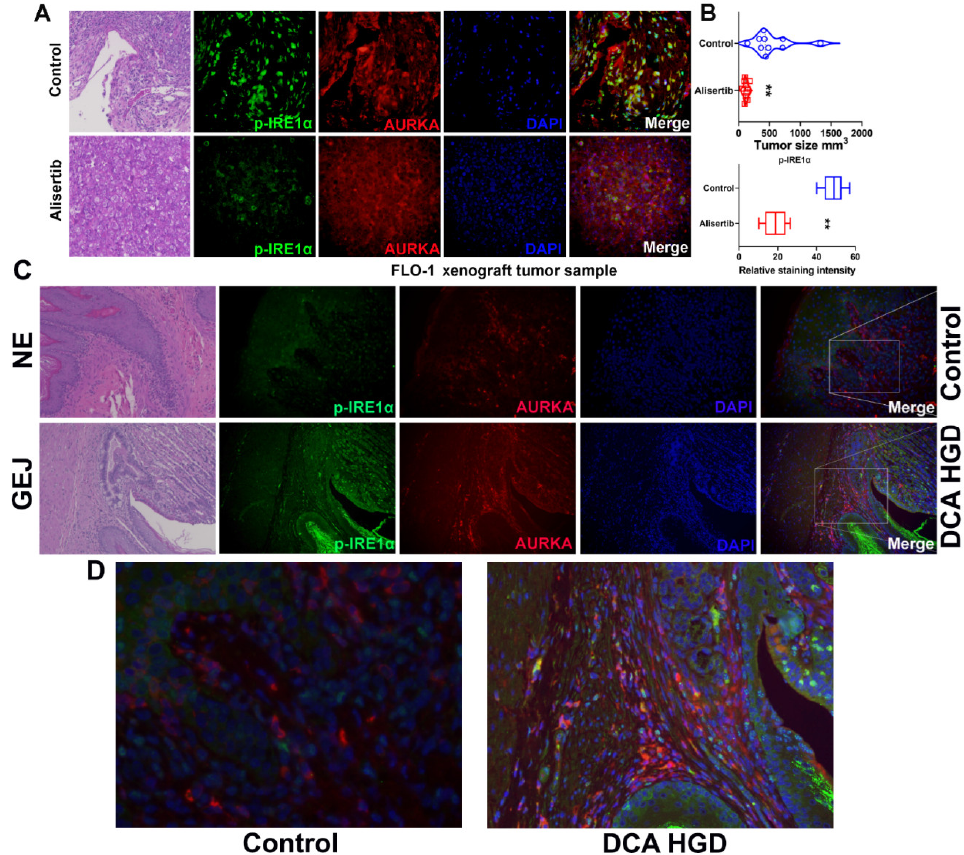
Figure 7. AURKA and ABS induce IRE1α phosphorylation in vivo. ( A ) H&E staining (left panels) and IF staining of p-IRE1α (S724, green signal), AURKA (red signal) in FLO-1 xenograft tumor samples with or without alisertib treatment. 200× magnification. ( B ) Upper panel: tumor size of FLO-1 xenograft tumors, 200× magnification. Lower panel: quantification of p-IRE1α staining in ( A ) using ImageJ. ( C ) H&E staining (left panel) and IF staining of p-IRE1α (S724, green signal), AURKA (red signal) in gastroesophageal junction tissues from the normal esophagus (NE) of wide-type mouse and high-grade dysplasia (HGD) of deoxycholic acid (DCA)-fed L2-IL1β transgenic mouse, 200× magnification. ** p < 0.01. ( D ) Partially enlarged picture of ( C ) 600× magnification.